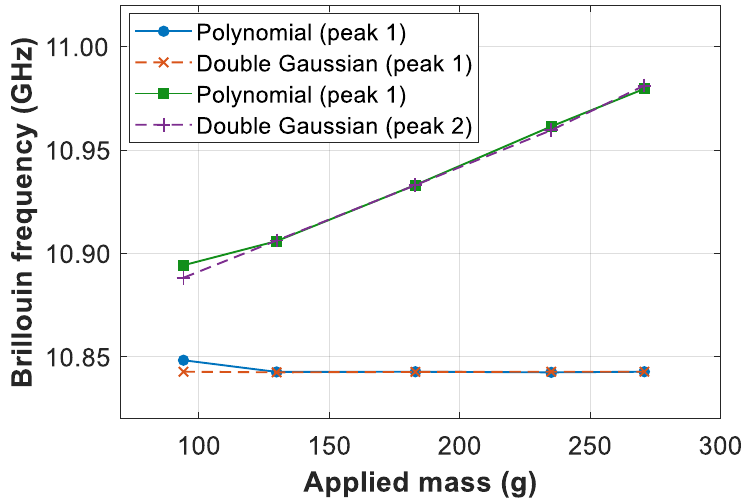
Figure 6. Estimated Brillouin frequencies obtained from 6th-order polynomial fitting and inde- pendent double-Gaussian fitting.